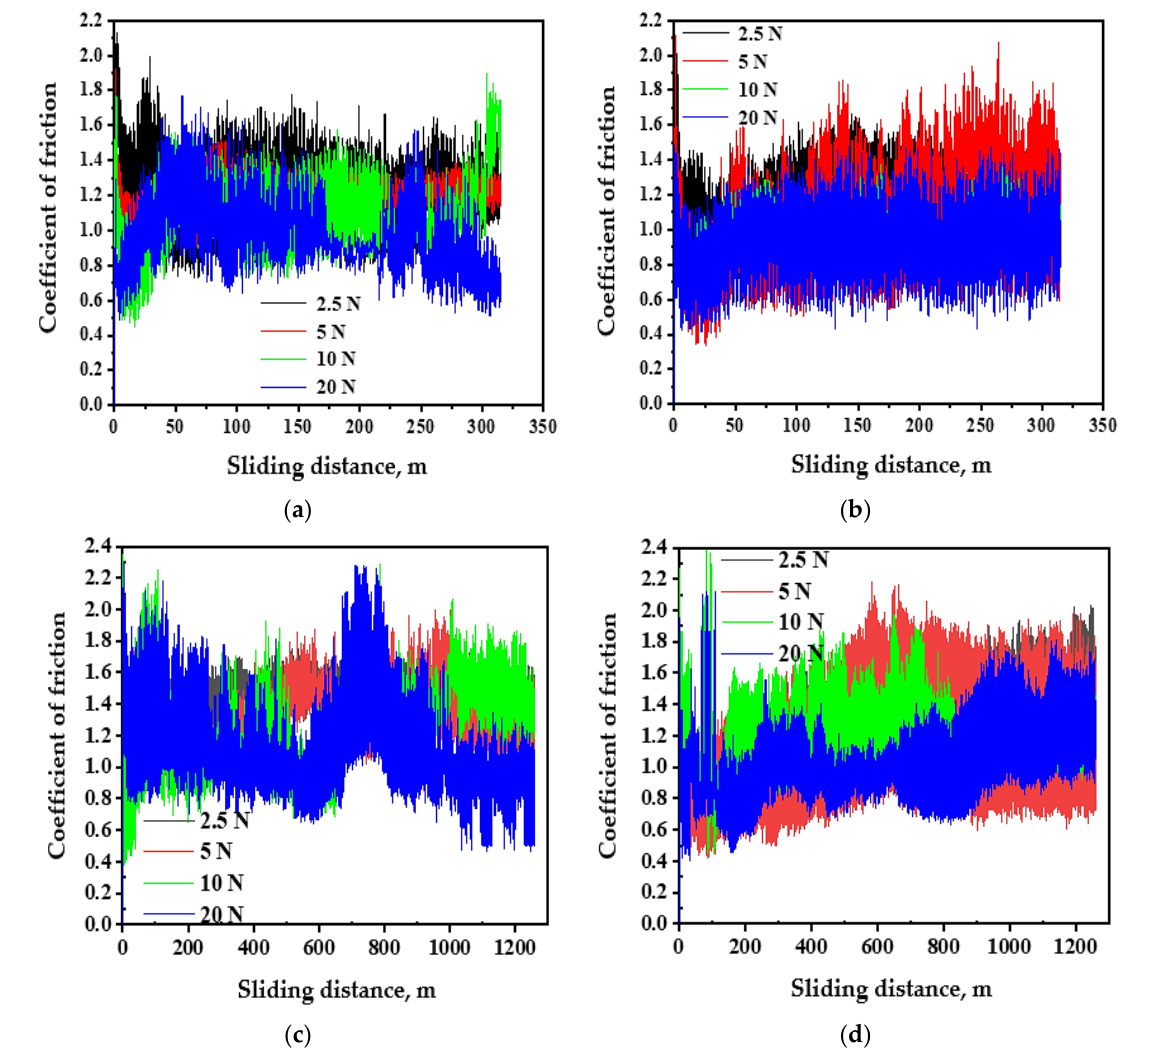
Figure 3. The COF curves of ( a , c ) PM Al and ( b , d ) HPT-processed Al samples under different applied loads and sliding distances of 315 and 1260 m.